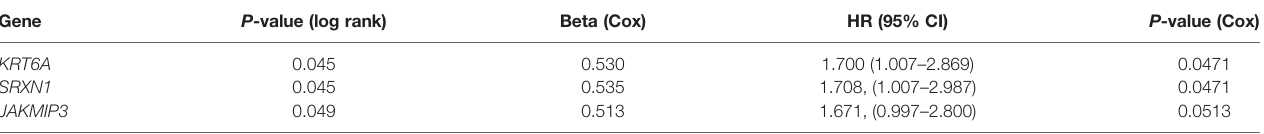
CI, con fi dence